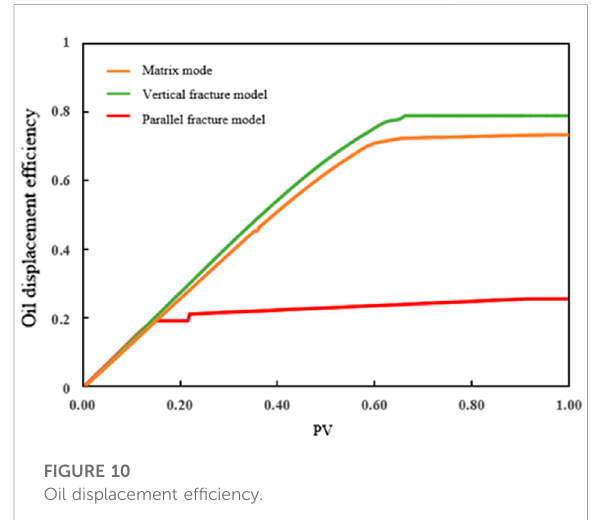
FIGURE 10 Oil displacement ef fi